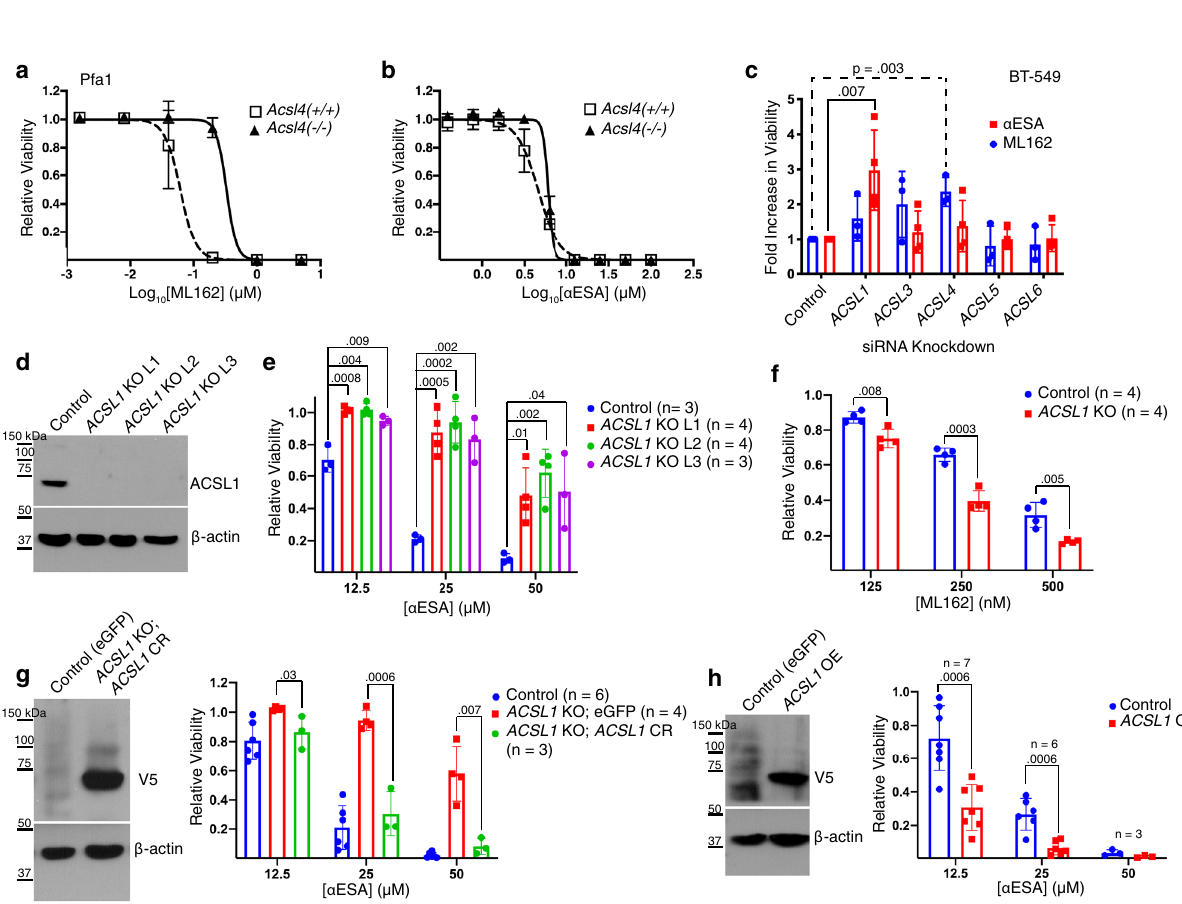
Fig. 4 Mechanistic analysis of α ESA-induced ferroptosis. a Relative viability (blue) and levels of total glutathione (red) in MDA-MB-231 cells after 24 h of treatment with 20 μ M BSO, or the speci fi ed dose of α ESA ( n = 2 independent experiments). b Densitometric quanti fi cation of GPX4 protein levels from western blots of lysates from MDA-MB-231 cells that were treated for 4 h with the indicated agent. n = 3 independent experiments. Error bars in this and subsequent panels represent standard deviation centered on the mean. p values in this and subsequent panels were calculated using two-sided Student ’ s t tests. c Cell viability over time for MDA-MB-231 cells treated as speci fi ed. * denote p values comparing viability of cells treated with ML162 and RSL3 to cells treated with α ESA and ML162. p values from left to right are 0.003, 0.0001, 0.02, and 0.008. d Cell viability dose-response curves for ML162 and the indicated dose of α ESA in BT-549 cells after 72 h of treatment ( n = 2 independent experiments). e Western blot showing GPX4 protein level in MDA-MB- 231 cells 48 h after transfection with a pool of GPX4 -targeted siRNA or non-targeting siRNA. β -actin is the loading control for this and the subsequent western blots unless otherwise speci fi ed. The right panel shows cell viability dose – response curves for α ESA in GPX4-depleted and control MDA-MB-231 cells ( n = 3 independent experiments). α ESA was added to cells 48 h after transfection for 24 h. f Western blot of endogenous GPX4 and exogenously expressed V5-tagged GXP4 in BT-549 and MDA-MB-231 cells. Relative viability of these cells after 48 h incubation with the indicated dose of g , ML162 ( n = 4 and 3 for BT-549 and MDA-MB-231, respectively) or h , α ESA ( n = 5 and 4 for BT-549 and MDA-MB-231, respectively). p -values from Student ’ s t-tests are shown. Relative viability of MDA-MB-231 or BT-549 cells after 48 h of treatment with the indicated dose of either i , ML162 or j , α ESA and vehicle, iFSP1, fer-1 (2 μ M), or iFSP1 and fer-1. Source data are provided as a Source Data fi le.